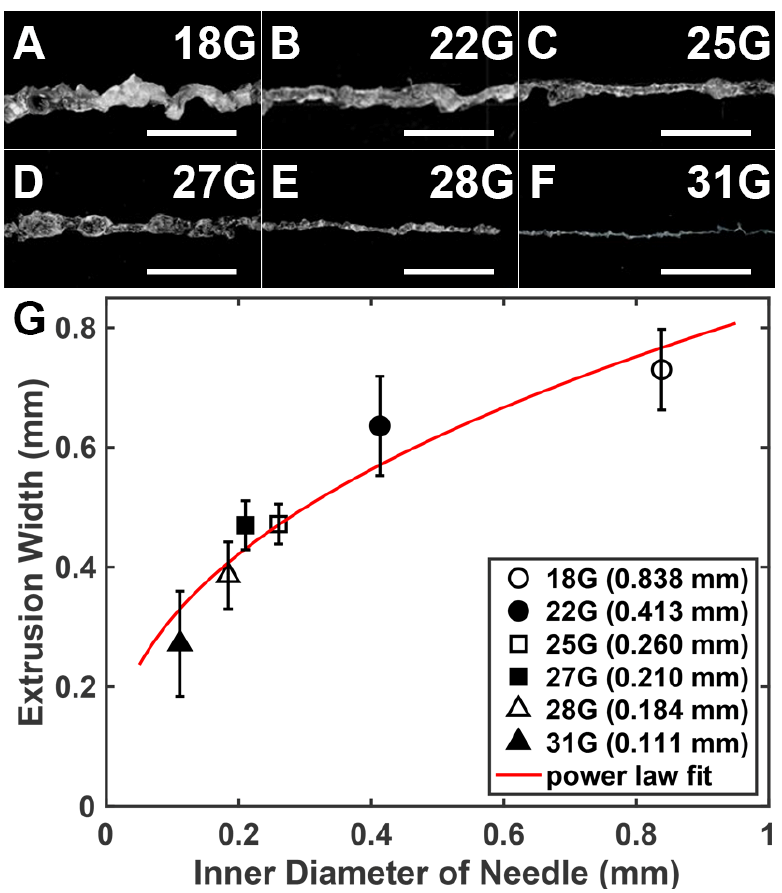
Figure 2. Widths of Capgel biomaterial ink extrusions from a range of different gauge needles follow a power-law relationship. ( A – F ) Stereomicrographs of Capgel needle extrusions; a needle gauge used for each is indicated in the upper right of each panel; ( G ) plot of average extruded line widths as a function of needle inner diameters (i.e., gauges). Scale bar = 5 mm for ( A – F ) and error bars = SD in ( G ).